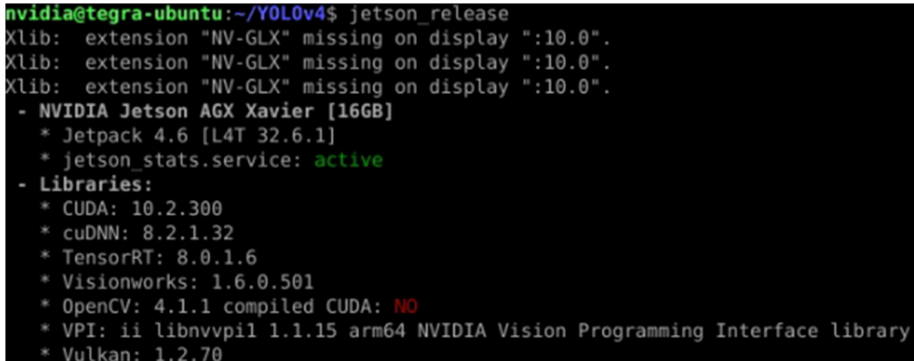
Figure 7. Check various library versions that make up the experimental